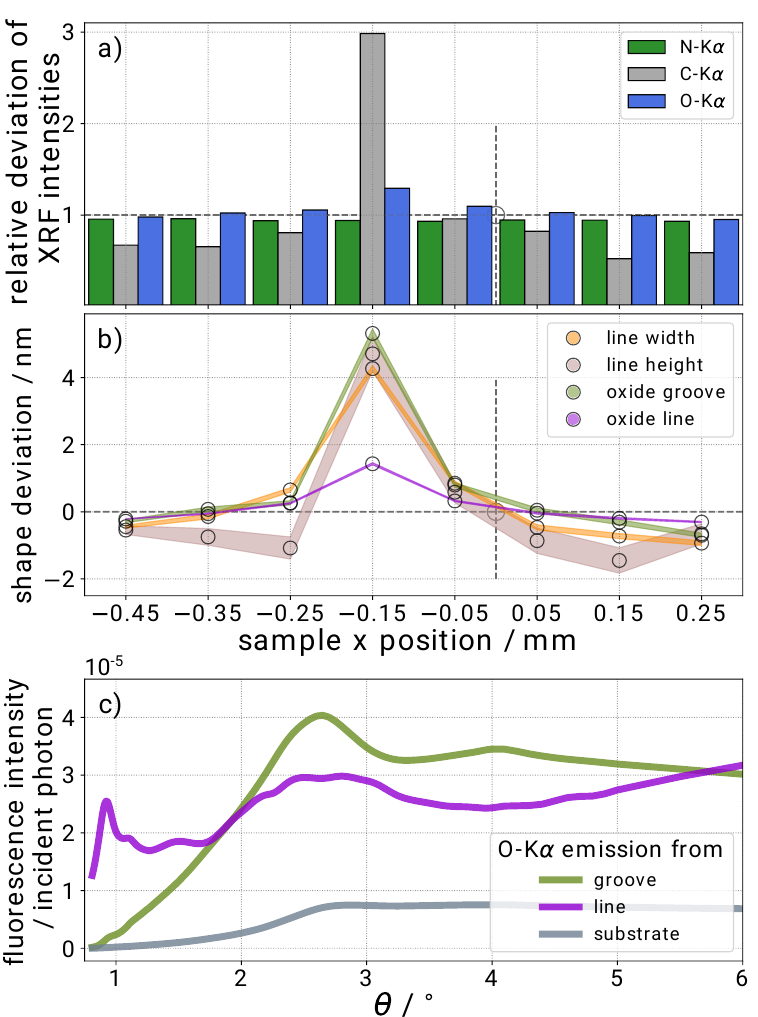
Figure 5. ( a ) Here, the C-K α , N-K α , and O-K α fluorescence intensities at θ = 15 ◦ where no XSW needs to be considered from different positions on the sample are compared. ( b ) The reconstruction results for the width, the height, the thickness of the oxide in the groove, and the thickness of oxide around the line for the different positions are plotted. ( c ) The various contributions from the line, the groove, and the oxide layer of the silicon wafer to the total oxygen fluorescence are